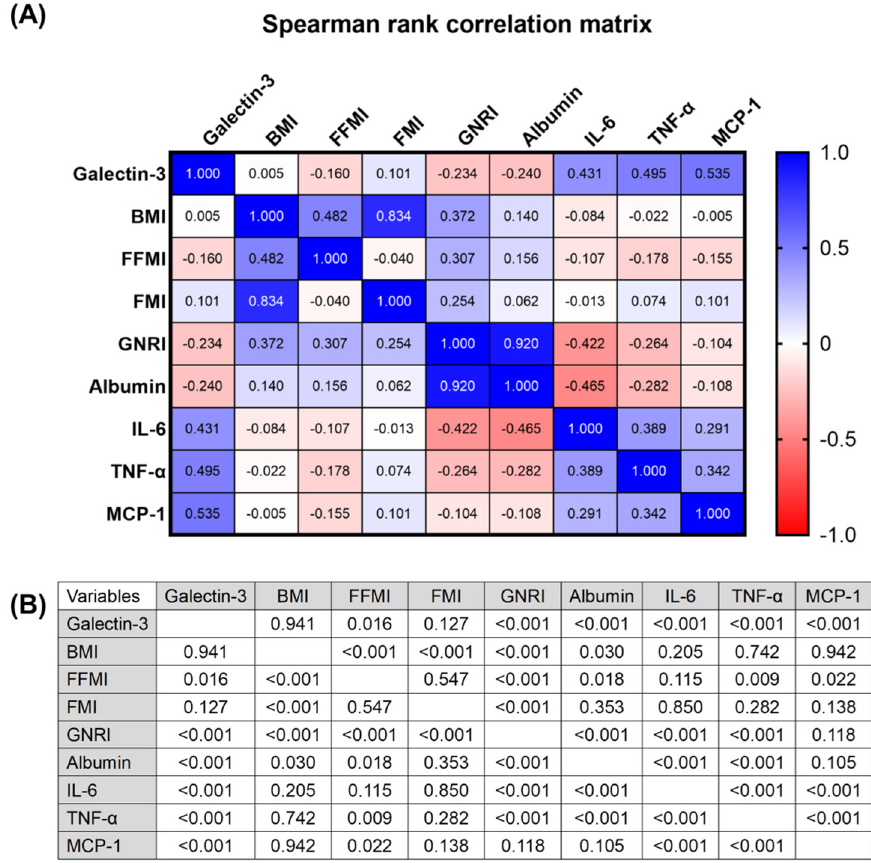
Figure 1. ( A ) The correlation matrix summarizes the strength of the association among body composition indices, systemic inflammatory factors, geriatric nutritional risk index, and plasma galectin-3 in adults undergoing maintenance hemodialysis. The numbers in each cell represent the value of the Spearman’s correlation coefficient. ( B ) The table represents the corresponding p values in ( A ).